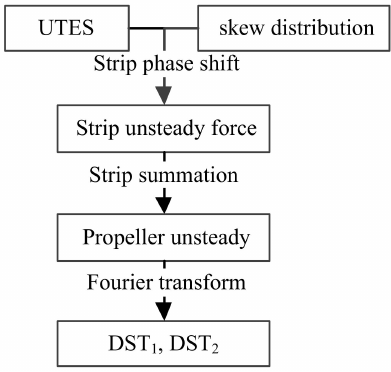
Figure 5. Flowchart of discrete-spectrum thrust (DST)